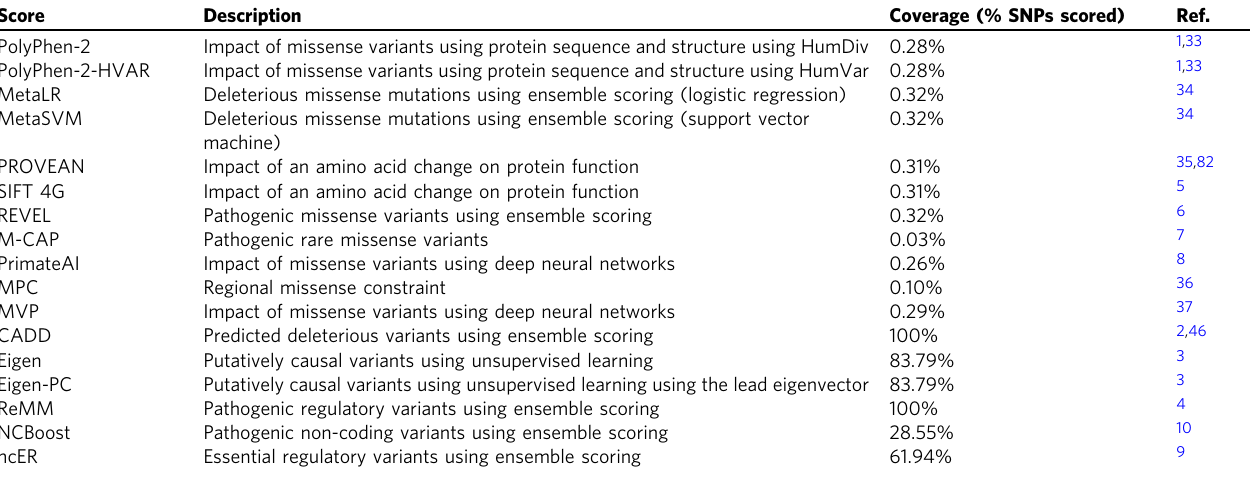
Table 1 11 Mendelian disease-derived missense and six genome-wide Mendelian disease-derived pathogenicity scores. Score Description Coverage (% SNPs scored) Ref.